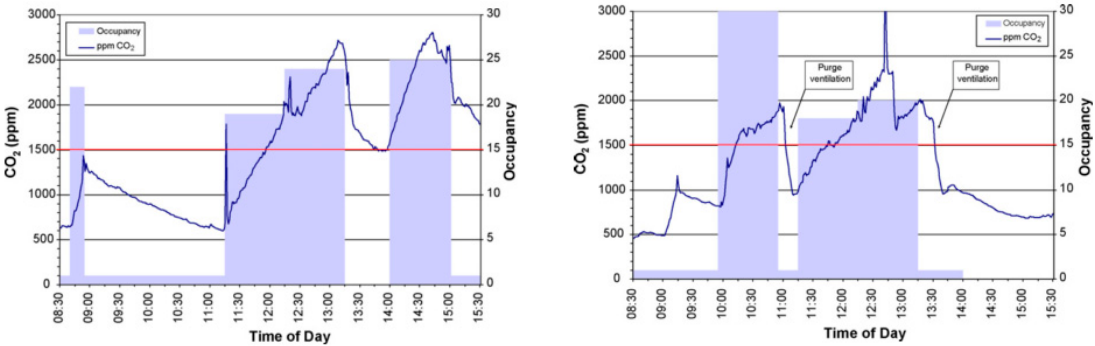
Figure 23. CO 2 and occupancy levels (Monday ( right ), Tuesday ( left )) [26].